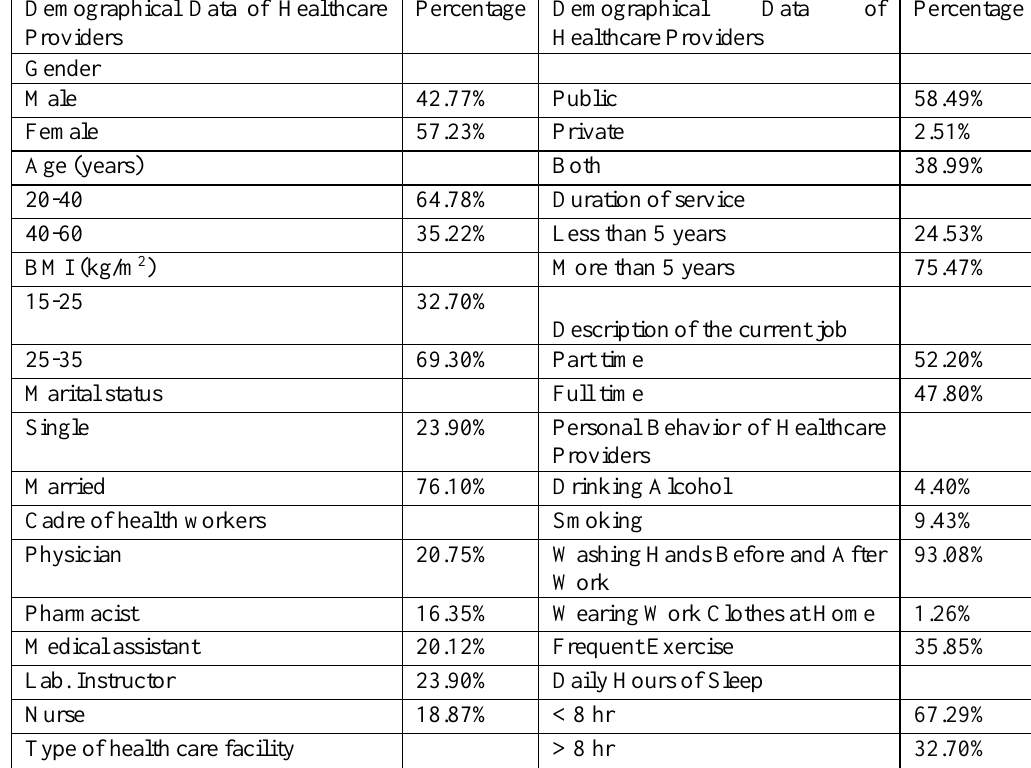
Table 1. Demographic Data of the Study